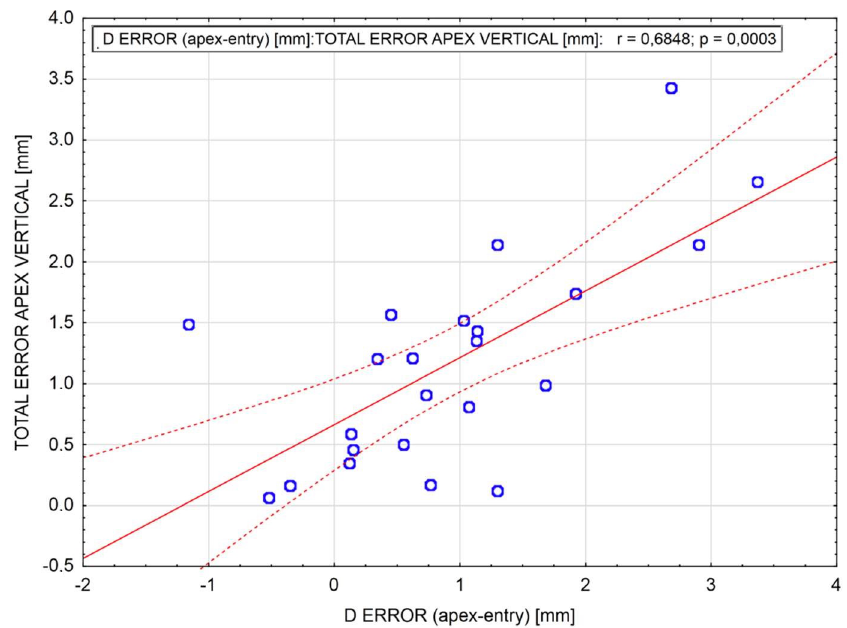
Figure 8. The correlation between the difference in errors at the entry and at the apex (DE apex-entry) and the vertical deviation (TE APEX VERTICAL).